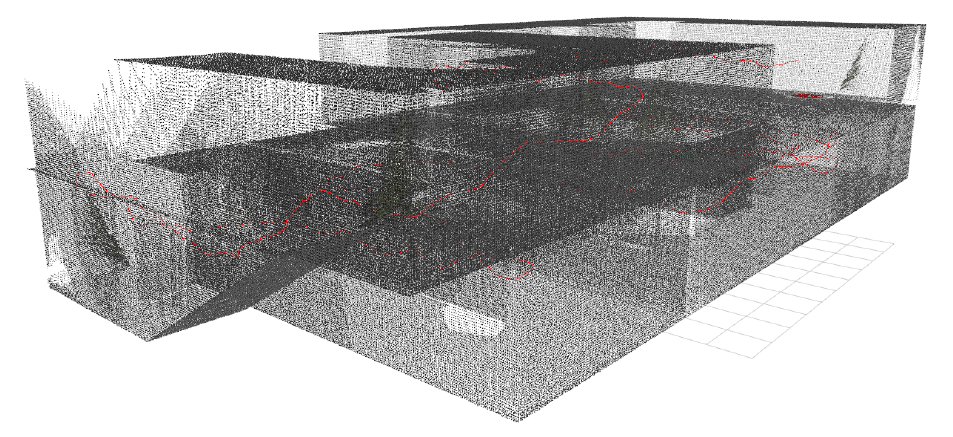
Figure 30. This figure illustrates the trajectory of the UAV from the starting location to the target location in the unknown environment from the staircase side (3D view).